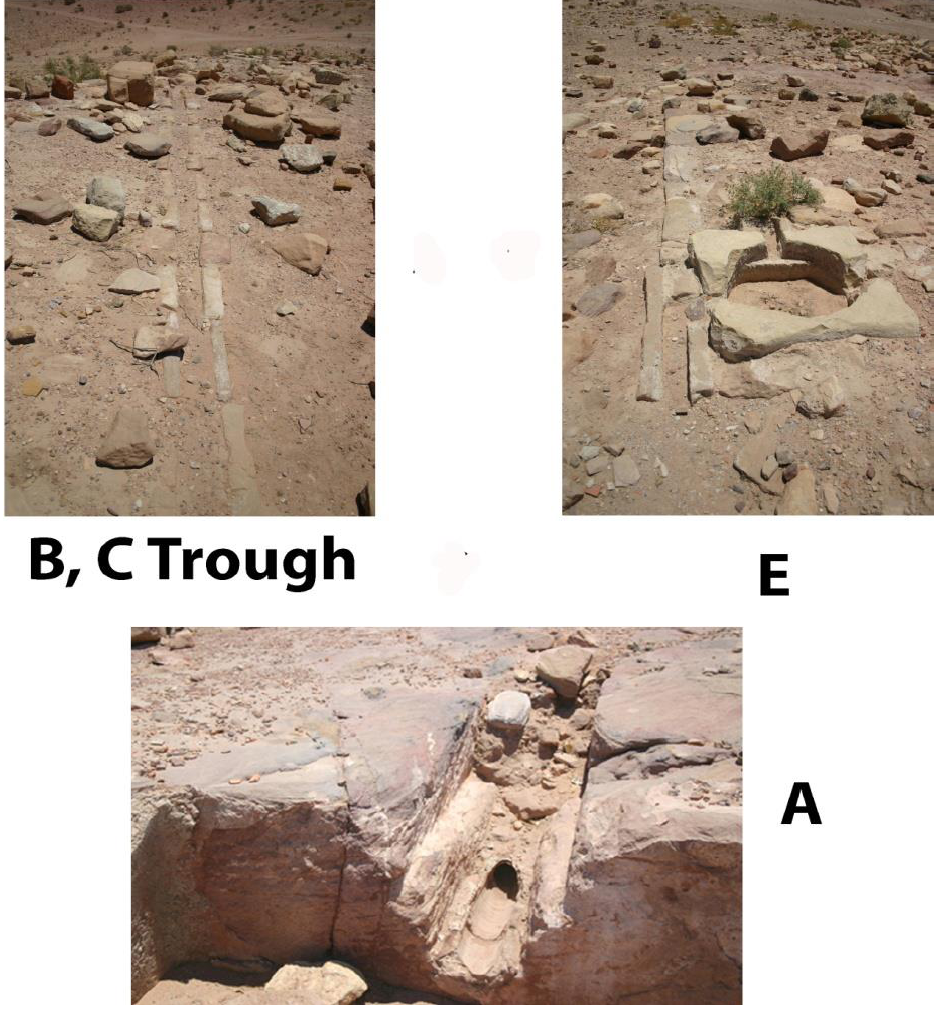
Figure 3. Assemblage components A–C and E of Figure 1, lower left hand B-2 corner of the El Habis hilltop pipeline water supply system. Photo by author on site in Jordan.